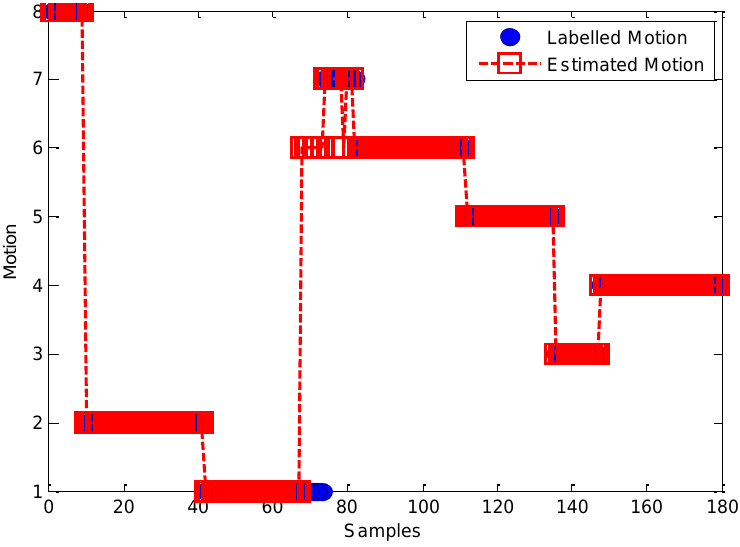
Figure 9. LS-SVM Motion state predictions (Motion state 1: ST, 2: SS, 3: WH, 4: WS, 5: WF, 6: UT, 7: US, 8: DS).